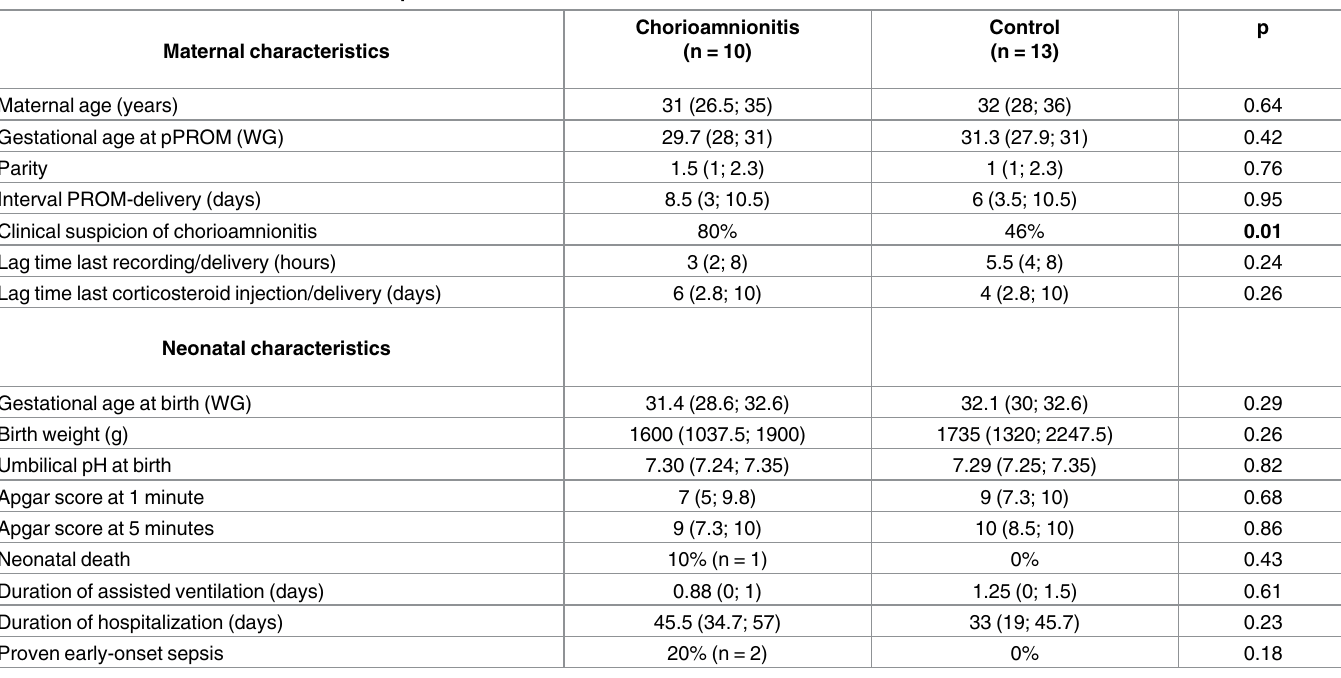
Table 1. Clinical characteristics in cases of pPROM with or without